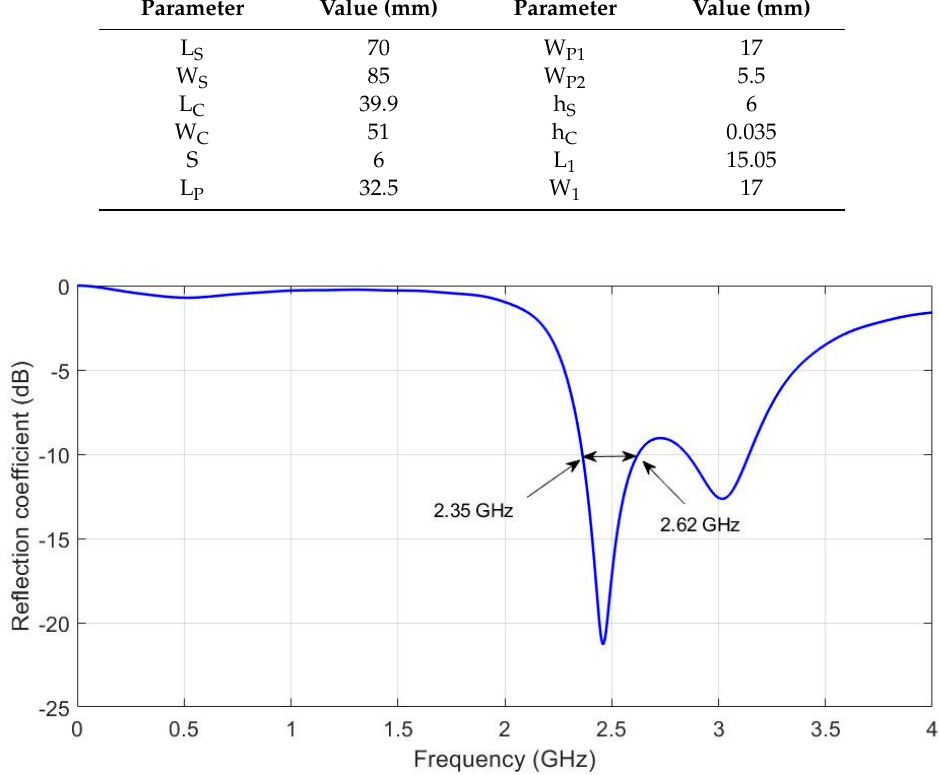
Figure 3. Reflection coefficient simulated response of the original antenna U-shaped patch prototype to a textile substrate.